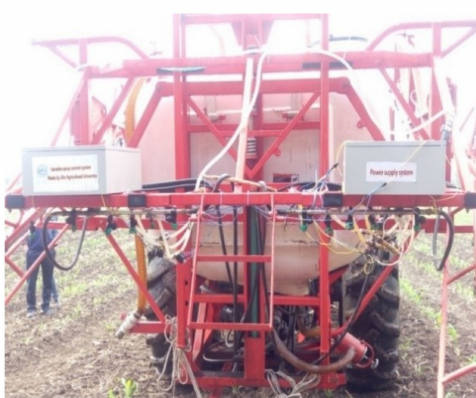
Figure 6. Field testing of the variable-rate spraying